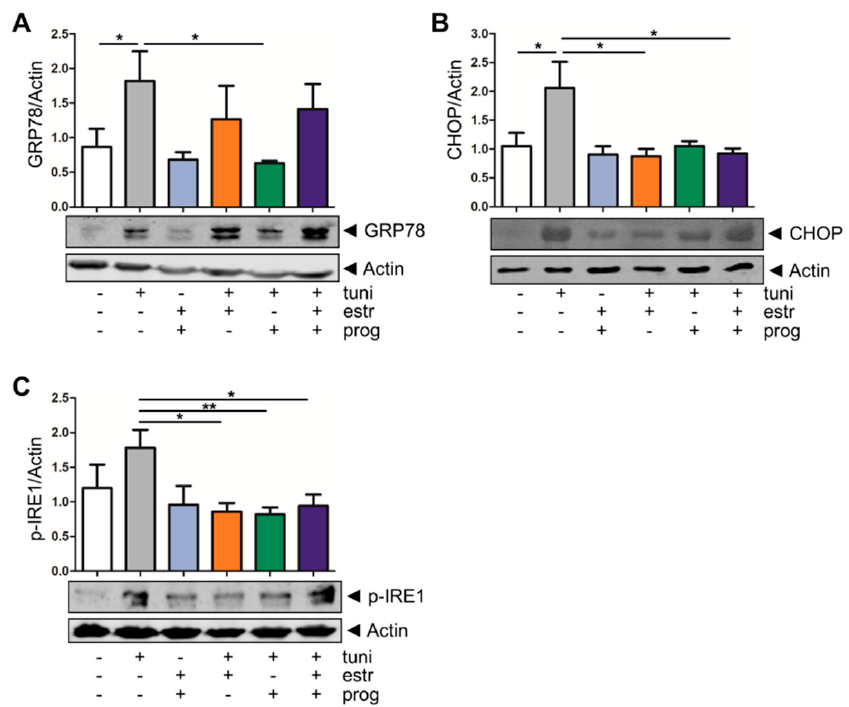
Figure 2. Sex hormones reduce endoplasmic reticulum (ER) stress in inflammatory bowel disease (IBD) organoids. Western blot analysis of the ER stress markers GRP78 ( A ) CHOP ( B ) and p-IRE1 ( C )